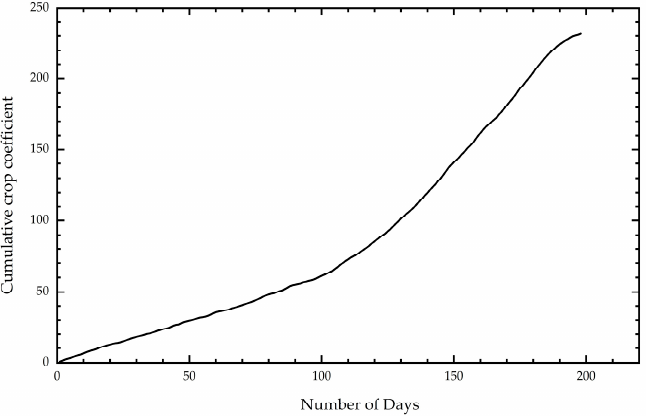
Figure 2. Correlation curve between cumulative crop coe ffi cient and days after